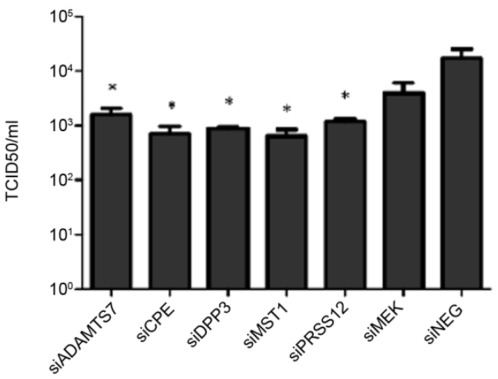
RNAi of individual host protease genes down-regulates replication of a clinical influenza isolate.A549 cells were reverse transfected with 100 nM of the novel siRNA targeting siADAMTS7, siCPE, siDPP3, siMST1, and siPRSS12. After 48 hours, cells were infected with A/New Caledonia/20/99 at an MOI of 0.1 in the presence of 1 ug/ml TPCK-trypsin. After 48 hours of infection, cellular supernatant was tested for infectious virus production by a modified TCID50. Data is expressed as TCID50/ml. Data is representative of two independent experiments. (*p<0.05 vs. siNEG).